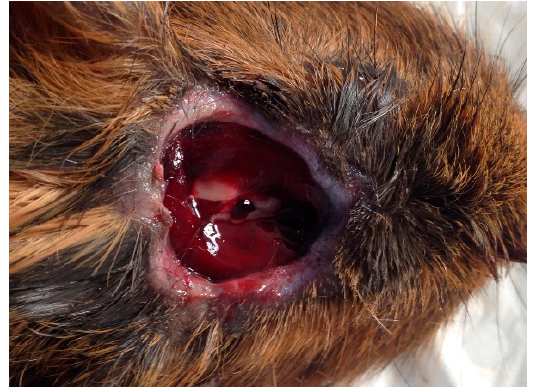
Figure 4. Skin removed from penetrative CB site .